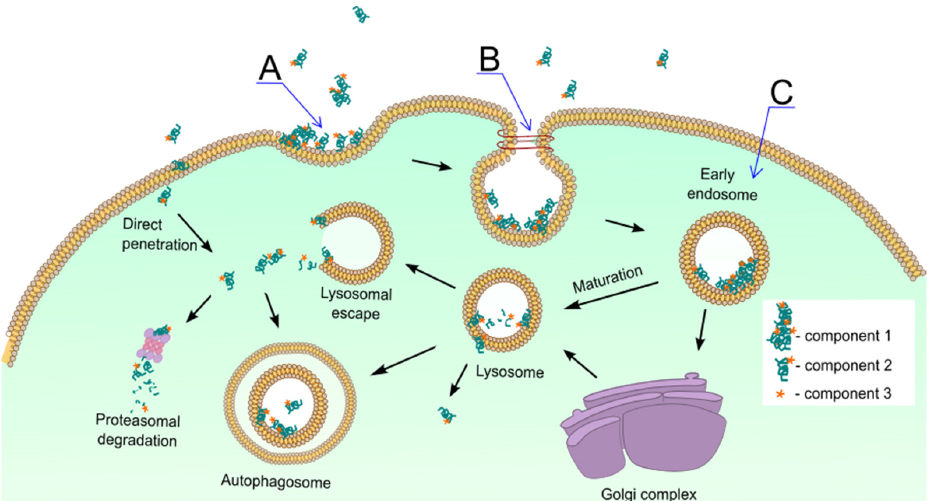
Scheme 3. Possible pathways of sRL2 trafficking inside the cell. A—an invagination of the surface of plasma membrane, B—endosome formation, C—formed endosome. Component 1—sRL2